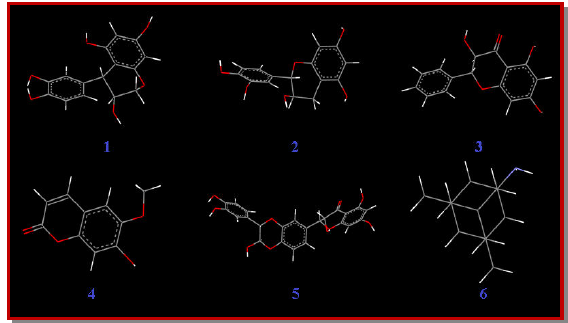
Figure 2: The optimized ligand molecules (1 acacatechin, 2 catechin, 3 galangin, 4 scopoletin, 5 silbinin, and 6 memantine)